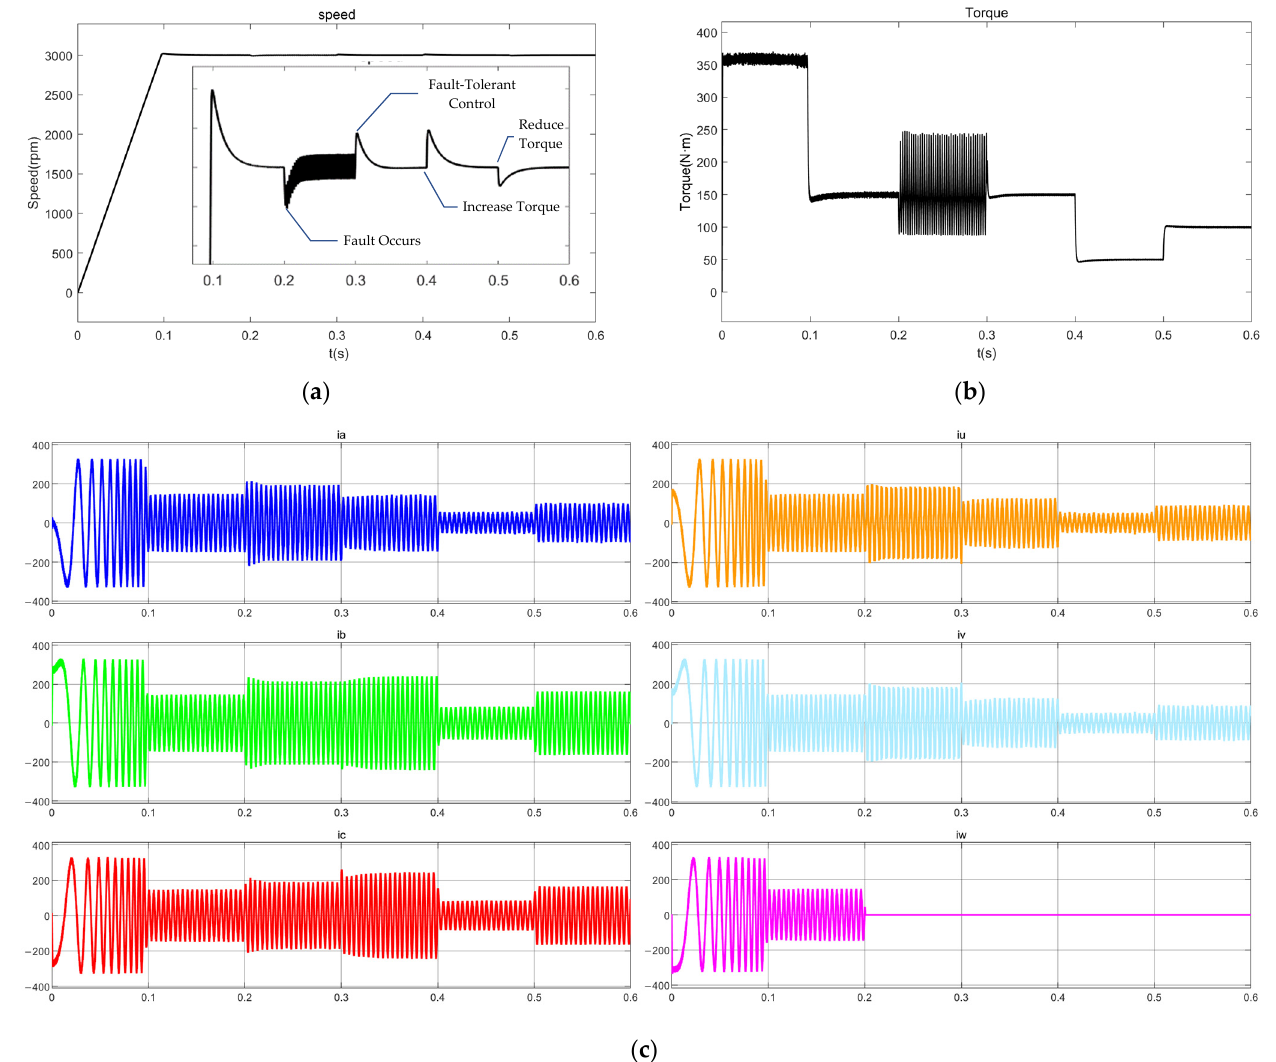
Figure 8. Simulation results of all periods under improved MRAS control. ( a ) Speed; ( b ) torque; ( c ) phase current.